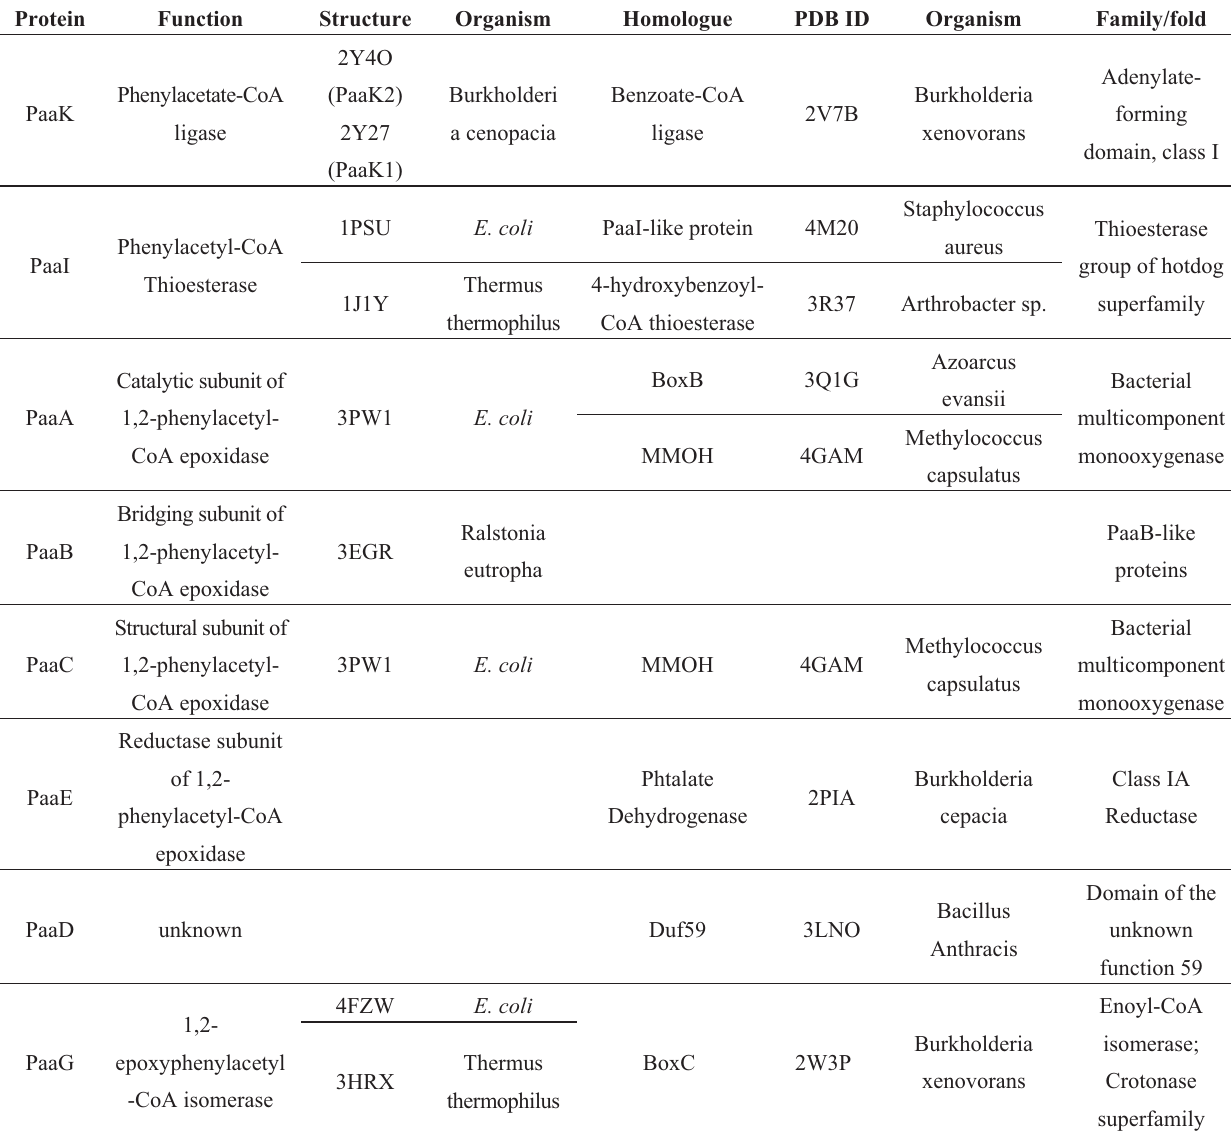
Table 1. General information about the enzymes from the phenylacetate degradation